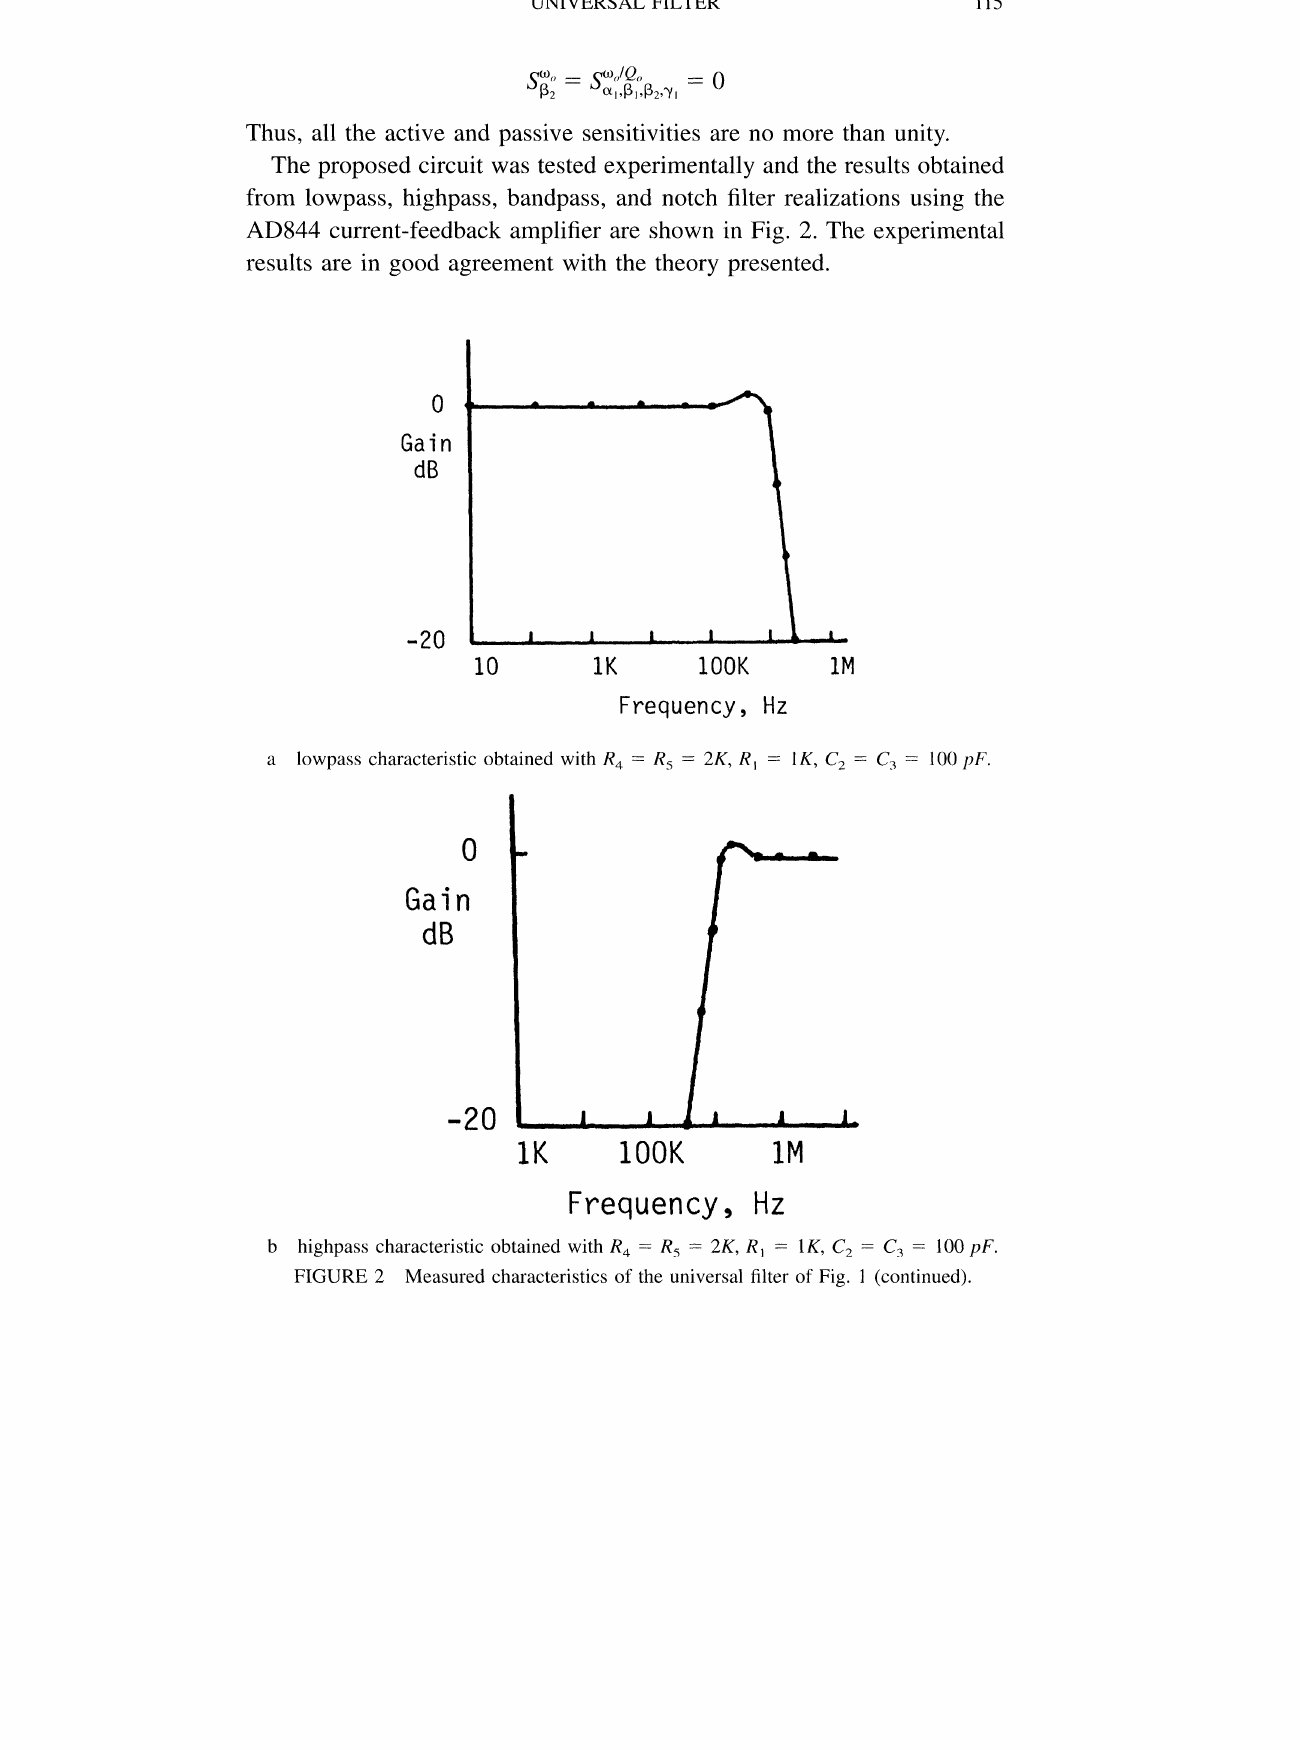
FIGURE 2 Measured characteristics of the universal filter of Fig.